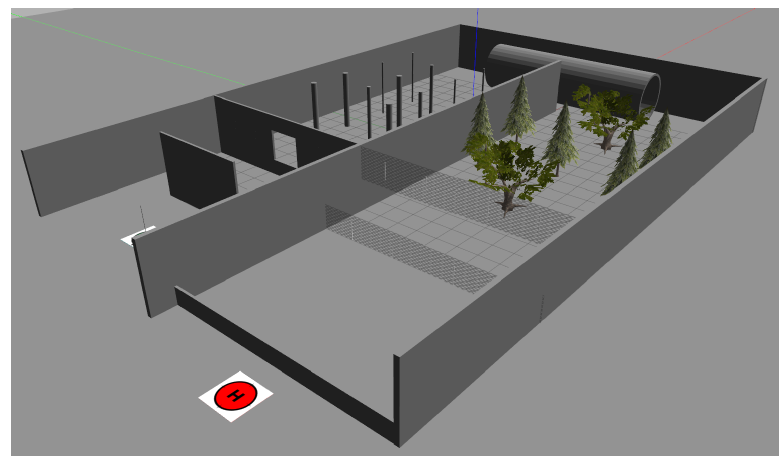
Figure 5. Training environment (3D view).